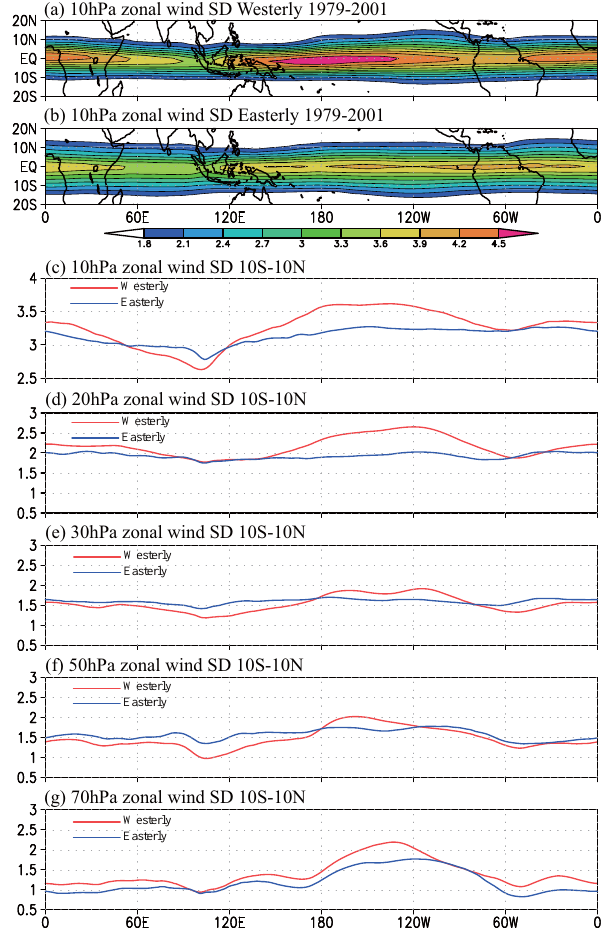
Figure 11. Horizontal distributions of the standard deviation among reanalyses at 10hPa during the (a) westerly and (b) easterly phase of the QBO averaged in the period 1979–2001. The color interval is 0.3ms − 1 . Longitudinal variations of the standard deviation at 10 ◦ S–10 ◦ N in (red) westerly and (blue) easterly phase at (c) 10, (d) 20, (e) 30, (f) 50, and (g)